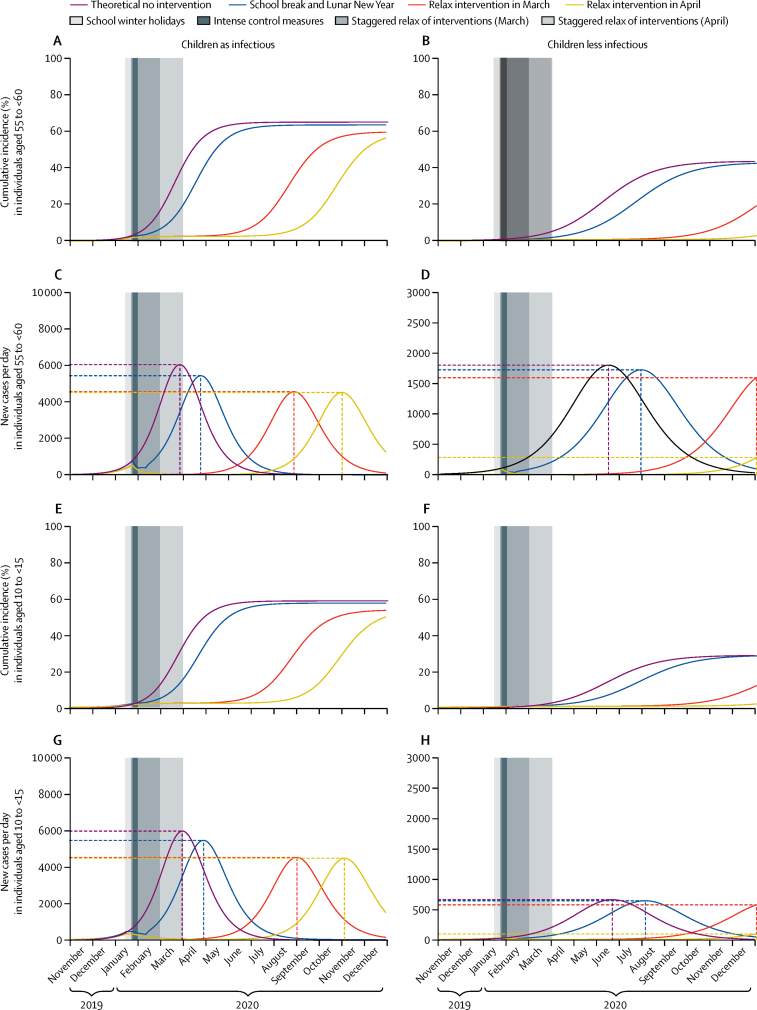
Effects of different intervention strategies on cumulative incidence and new cases per day among individuals aged 55 to <60 years (A to D) and 10 to <15 years (E to H) from late 2019 to end-2020